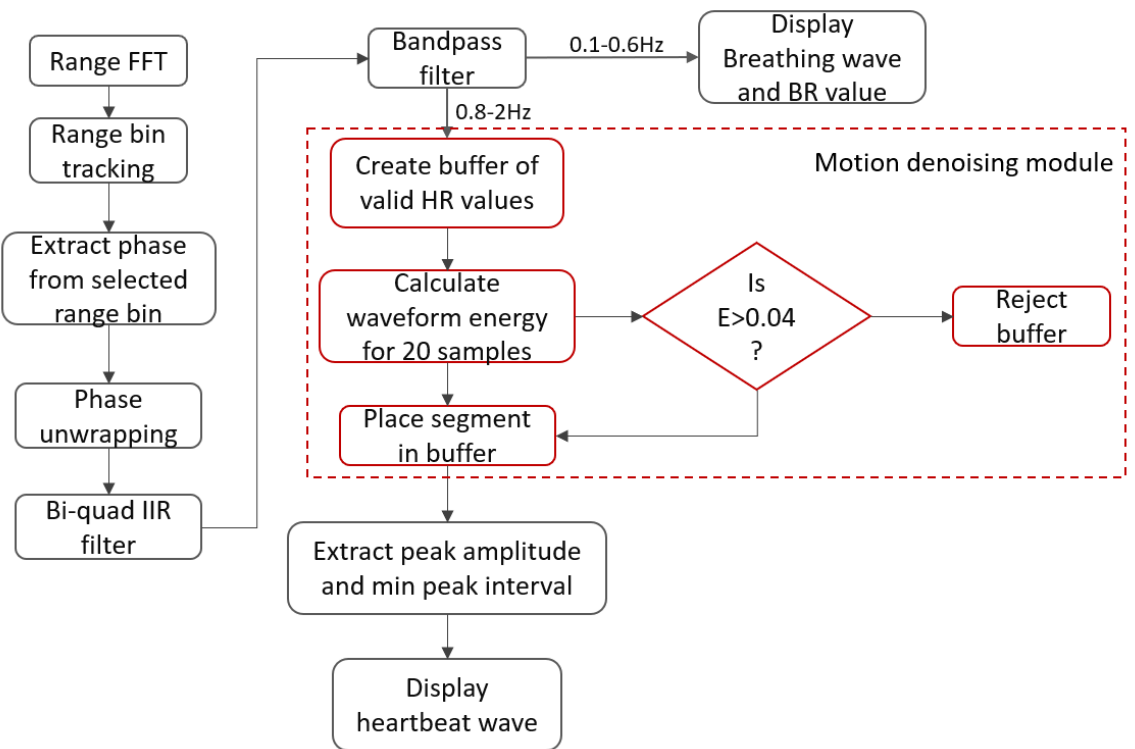
Figure 4. Signal processing workflow: after applying the range FFT, for a single range bin, the angle FFTs are computed, upon which the phase shift is used to extract the heartbeat and breathing waves. Table 1. Vital signs measurement parameters.